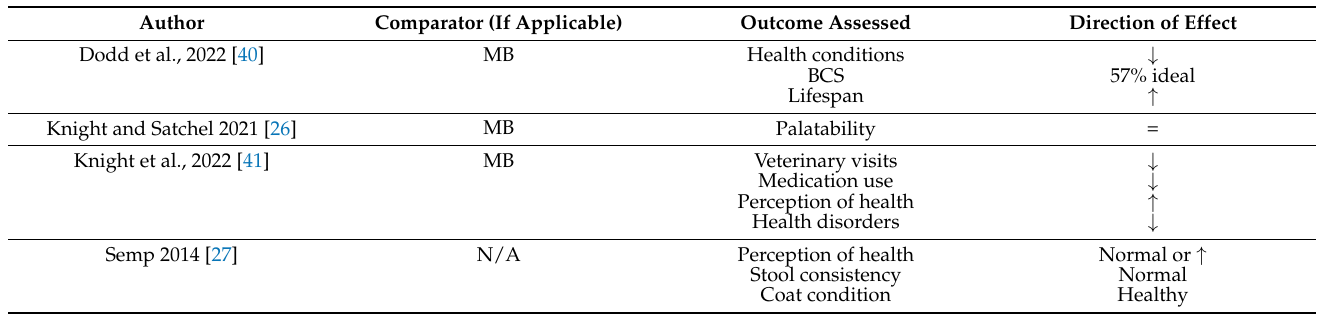
Table 4. Direction of effect of guardian-derived parameters in dogs fed vegan